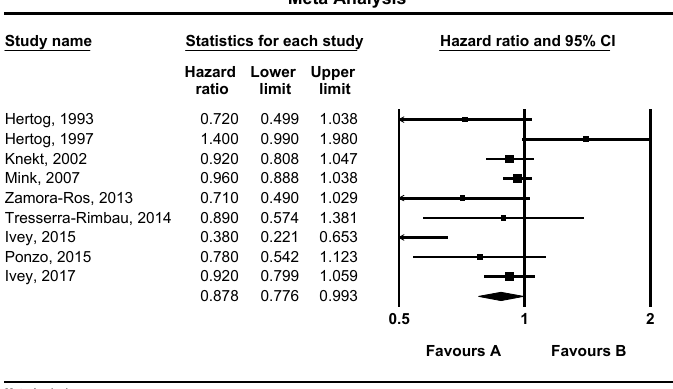
Figure 3. Forest plot of flavonoid intake and risk of cardiovascular disease mortality.